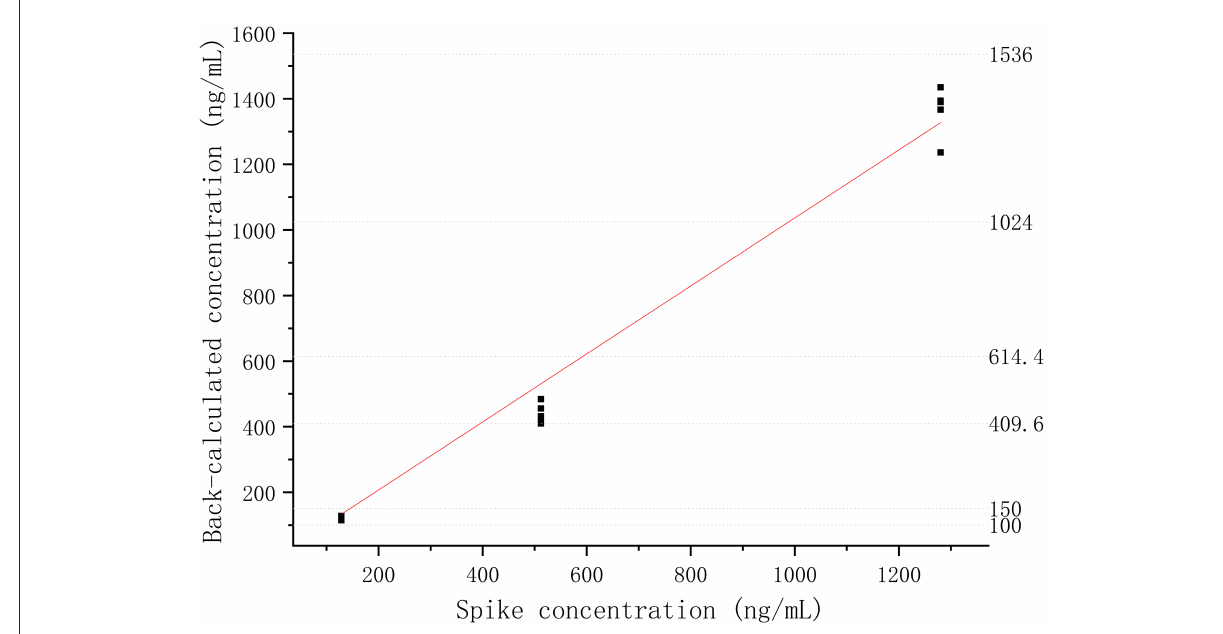
FIGURE3 Dilutional linearity of the recombinant canine PD-1 fusion protein in drug-free plasma assessed by precision and accuracy ( R 2 > 0.99).